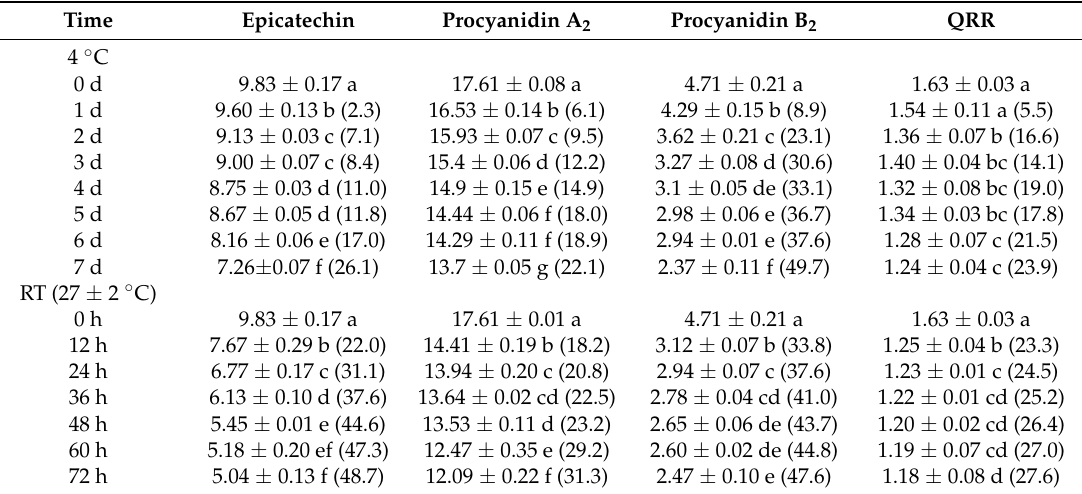
Table 1. Changes of phenolic compositions and contents in litchi pericarp stored at 4 ◦ C and at RT (27 ± 2 ◦ C) (mg/g dry weight (DW)). Values with no letters in common in each column are significantly different ( p < 0.05). Values in parentheses indicate decrease percentage to the contents of each individual phenolic in litchi pericarp during storage,